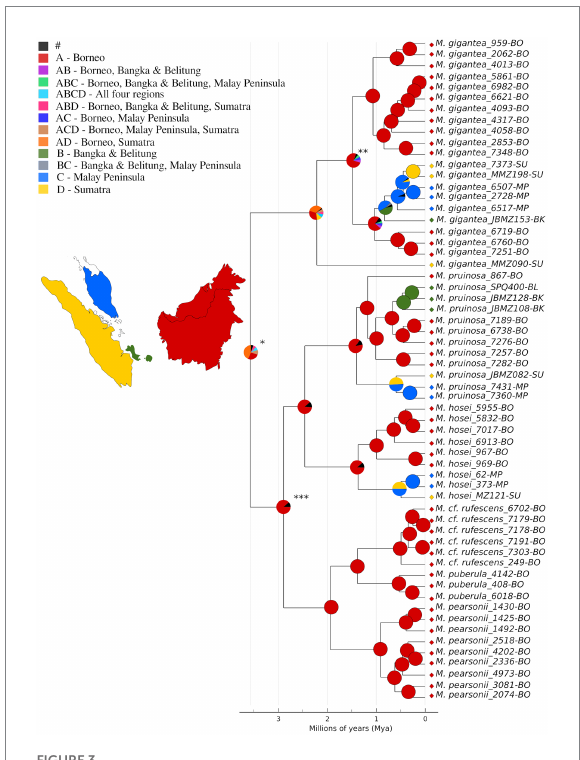
FIGURE 3 Ancestral area reconstruction according to the DEC + J model calculated by implementing six BioGeoBEARS models on RASP. Pie figures at each node represent geographical area or a combination of geographical areas occupied by ancestral taxa as inferred in the analysis. Colors used to represent areas and combination of areas are as indicated in the legend. The width of the wedges in the pie figures is proportional to the probability of that area or combination of areas; black colored wedges (#) indicate the sum total of all the areas or combination of areas that received probabilities <5% in the analysis. Colored diamonds at the tips indicate the present-day distributions of the respective individuals. Asterisks mark the crown node of section Pruinosae (*), MRCA of M. gigantea clade excluding the admixtured individual (MMZ090; **), and the crown node of the myrmecophytic clade of the section (***) as referenced in the text. Individuals are named in the following format: Species name_accession number-geographical distribution (BO,